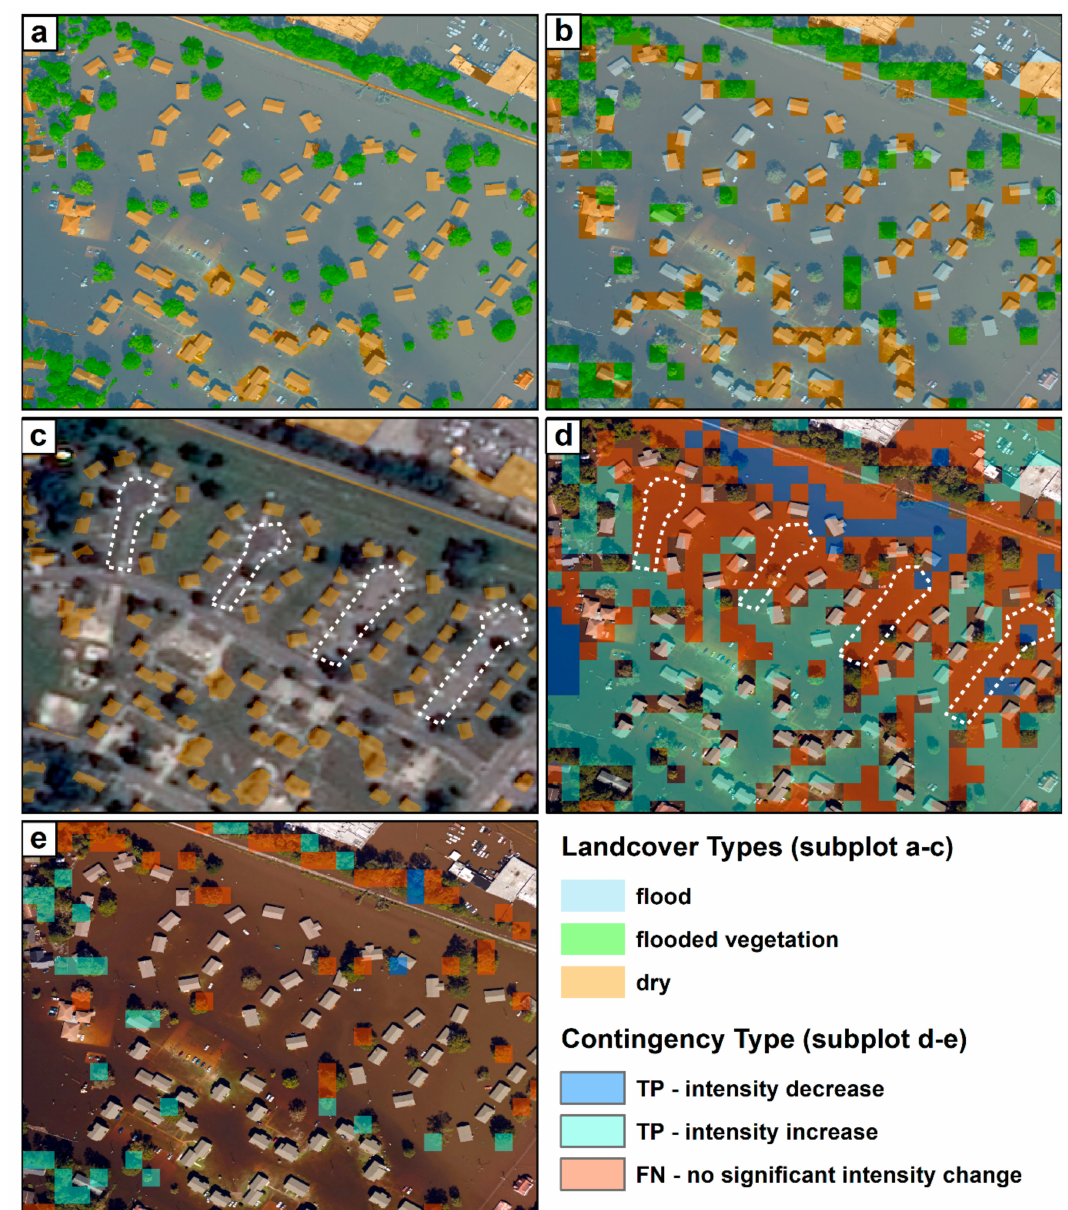
Figure 11. The during-event aerial photo for patch 1 (see Figure 6a for location), overlaid with ( a ) the land cover classes in vector format, and ( b ) the rasterized land cover map in 15 × 15m resolution. ( c ) The pre-event satellite image overlaid with the Dry class for reference. The white dashed lines represent asphalt driveways. ( d ) The contingency map for the Flood class. ( e ) The contingency map for the Flooded Vegetation